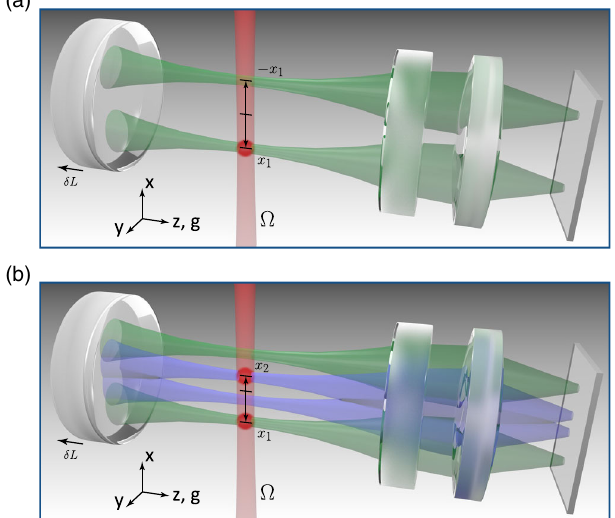
FIG. 1. Sketches of experimental configurations employed. (a) A 87 Rb BEC (red circle) is trapped at the cavity waist z ¼ 0 at a location x 1 relative to the cavity center. The transverse pump beam (red beam) propagates along ˆ x ; the system undergoes a super- radiant, self-organization phase transition above a critical field strength Ω . Photons scattered off the BEC into the modes of the c confocal cavity (green) create a virtual image (not shown) of the BEC at − x 1 . The distance δ L indicates the tunable offset of the mirror from the confocal configuration. Emission of intracavity photons can either be sent to a single-photon counter or imaged onto an EMCCD camera to resolve the spatial structure of superradiant emission. An absorption imaging laser for imaging BEC density travels along ˆ y (not shown). (b) Two 87 Rb BECs trapped at locations x 1 and x 2 on opposite sides of the cavity center. Images of the two BECs are created at − x 1 and − x 2 (not